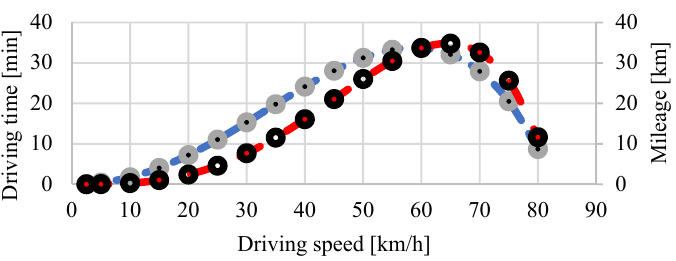
Figure 3. Distribution of driving time and mileage as a function of driving speed (V max = 80 km/h; V avg = 50 km/h; A = 3.25; B = 1.92) [27].